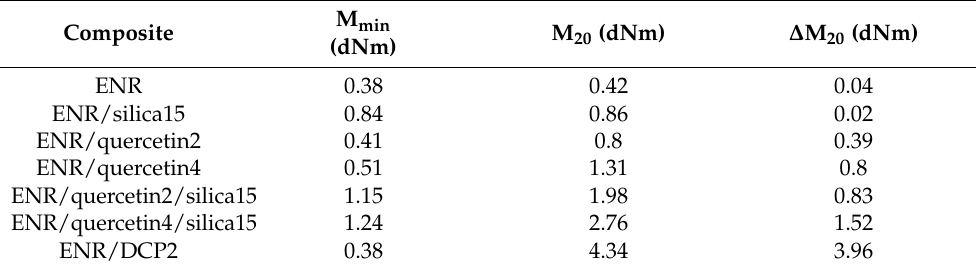
Figure 2. Analysis of curing effectiveness of ENR-50-based materials in a function of time ( a ) and values of the minimal torque (M min ), maximal torque (M max ) and torque increase ( ∆ M) of the same materials ( b ). Table 2. Values of the minimal torque (M min ), torque after 20 min of curing (M 20 ) and torque increase after 20 min of curing ( ∆ M 20 ) of the same